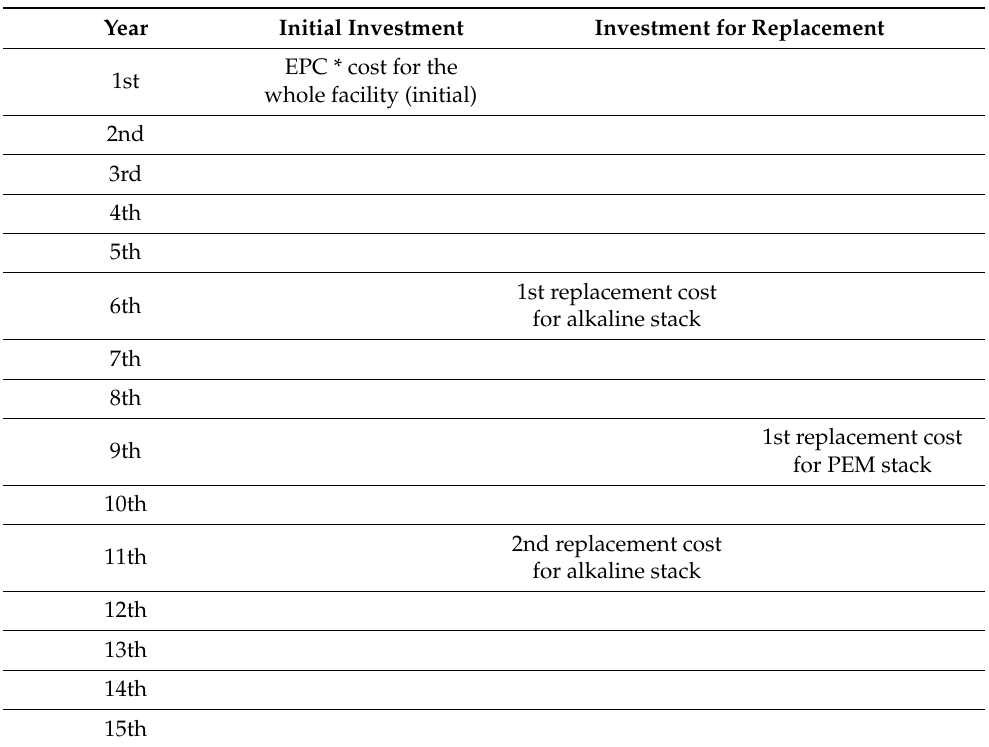
Table 6. Time of occurrence for CAPEX during the entire business